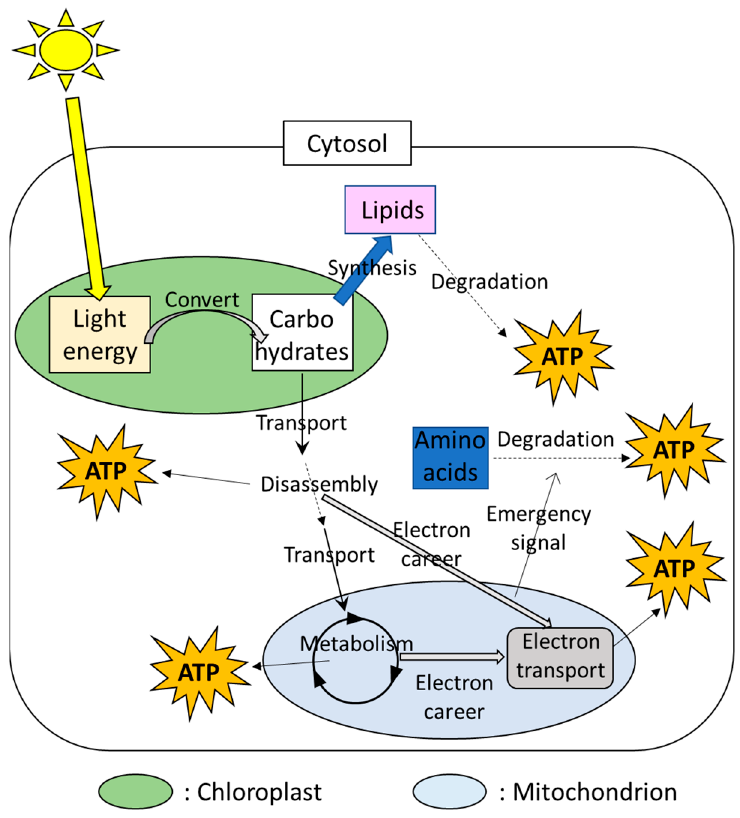
Figure 1. Multiple ATP-producing systems in a plant cell involving the chloroplasts and